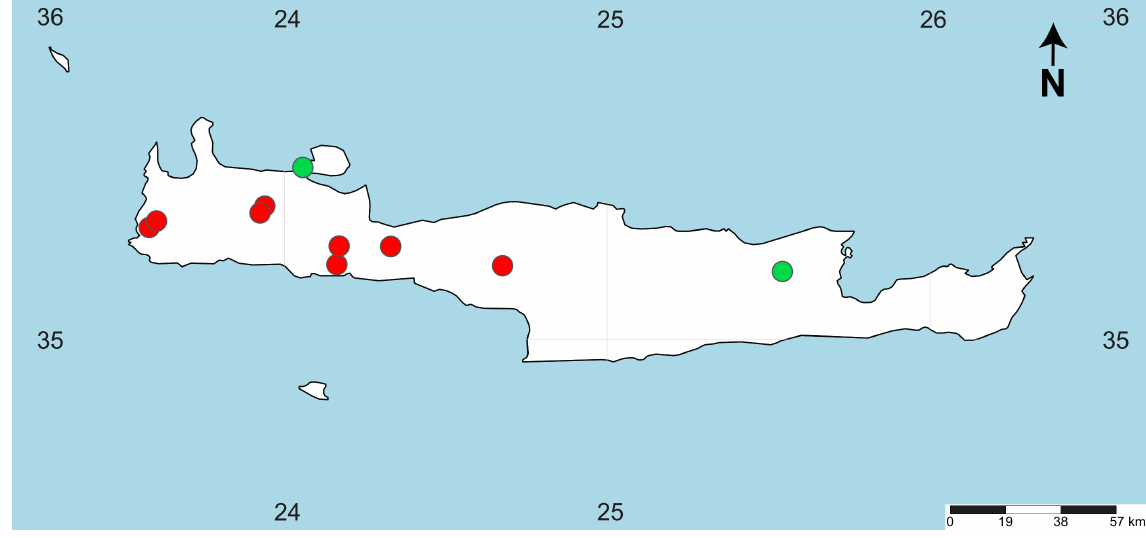
Fig. 1. Locations on Crete, Greece where Milesia cretica Bot & van Steenis sp. nov. was observed (green circles) or collected (red